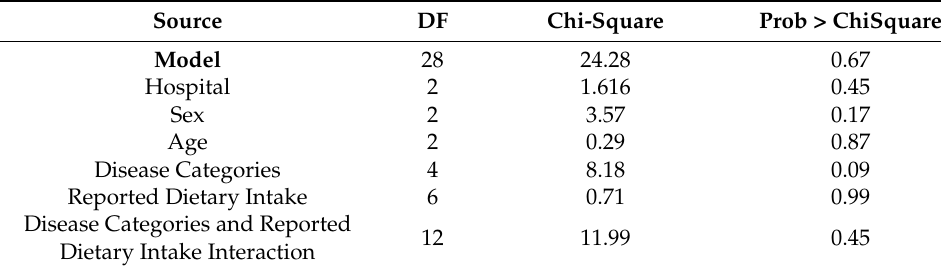
Table 6. Logistic model